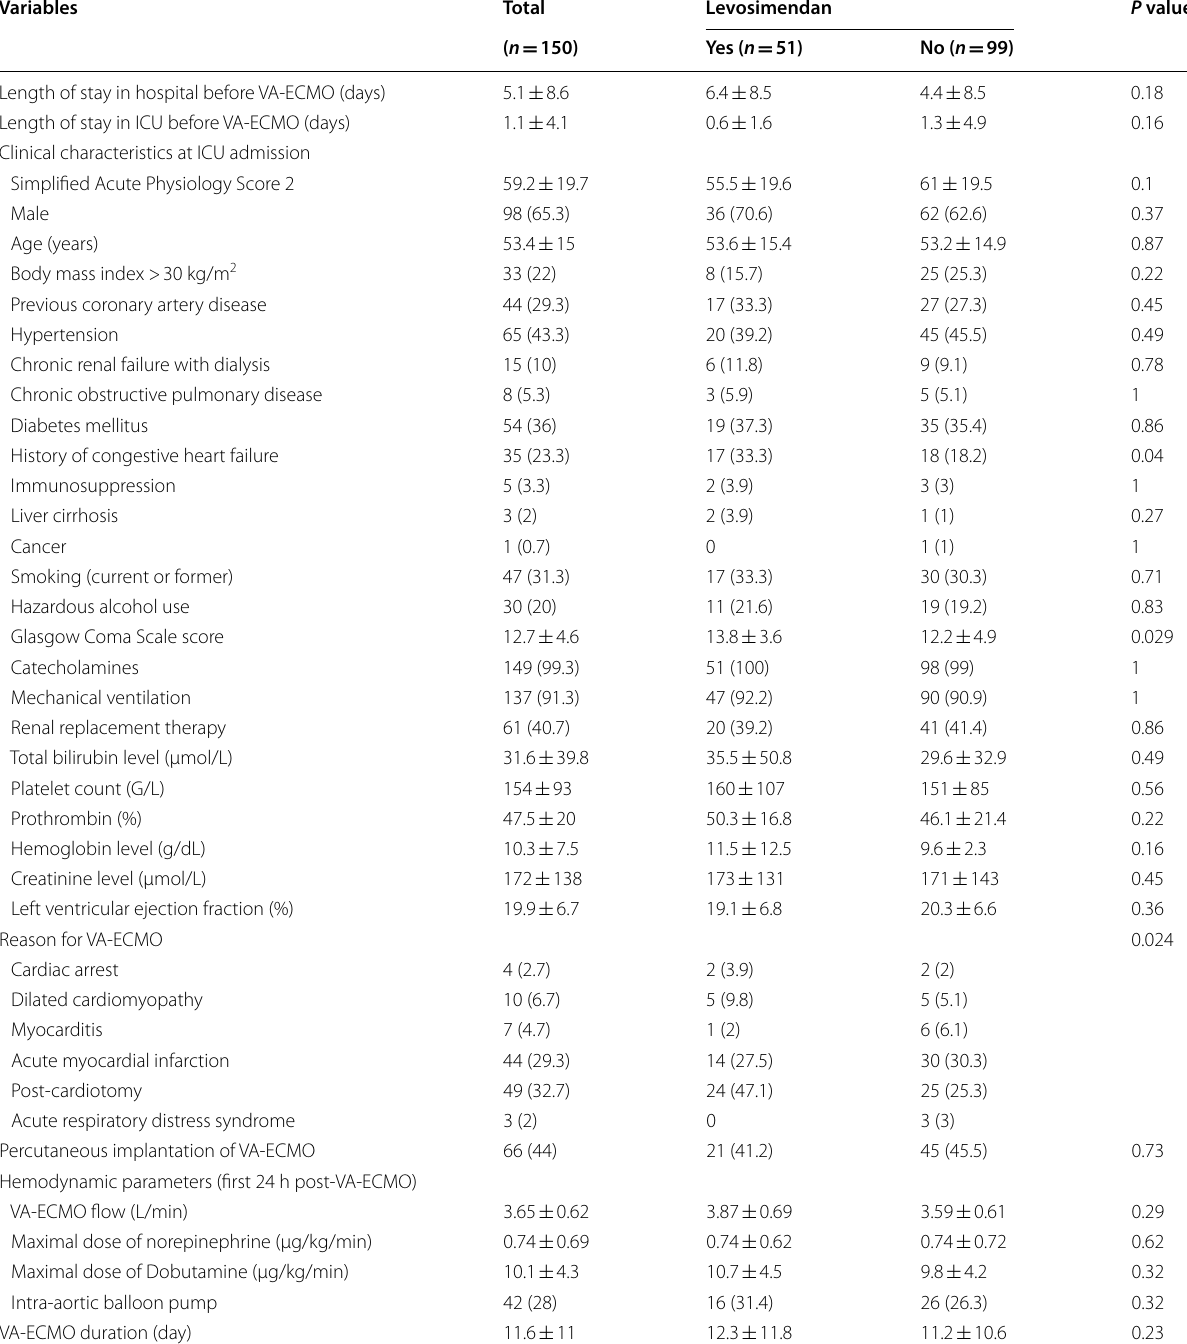
Table 1 Baseline patient characteristics in pre-matched